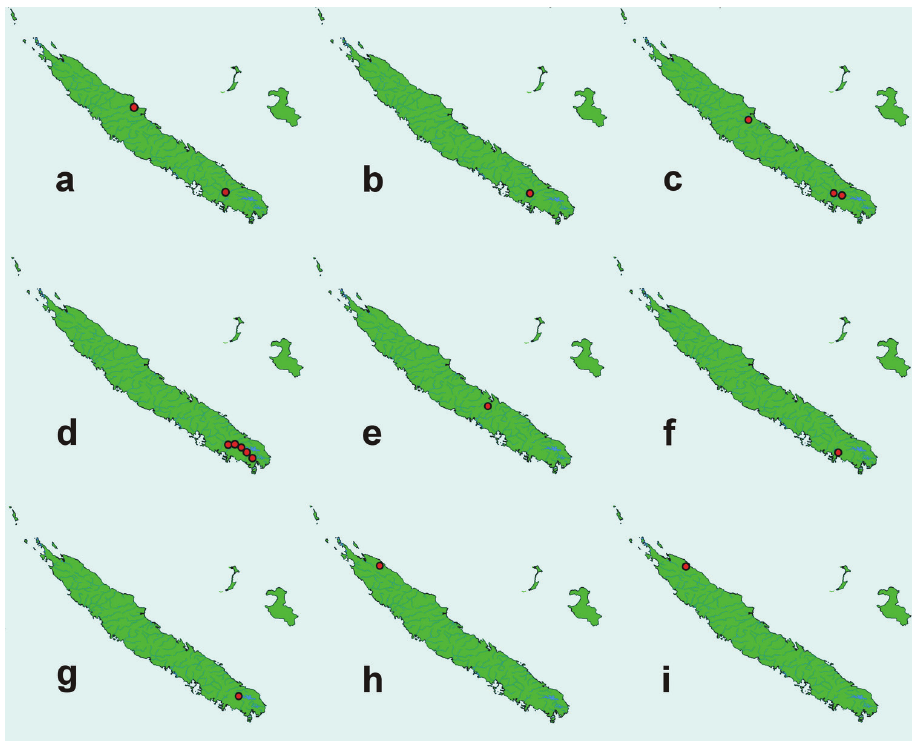
Figure 145. Distribution maps of New Caledonian species of Callistomorphus : a C. farinosus Perr. b C. fundatus sp. n. c C. gibbus sp. n. d C. malleus sp. n. e C. minimus sp. n. f C. rutai sp. n. g C. szoltysi sp. n. h C. torosus sp. n. i C. turbidus sp.